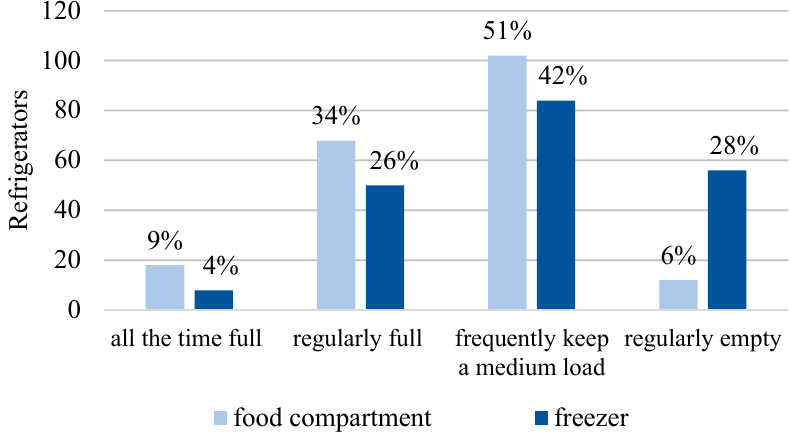
Figure 1. Distribution of thermal load in the refrigerator. 128